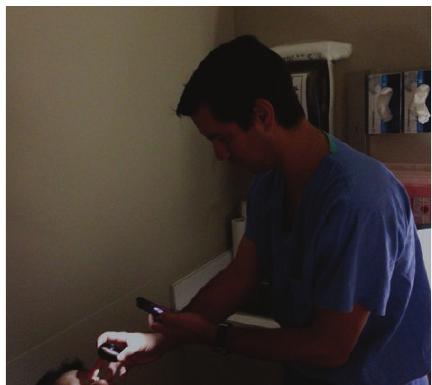
Figure 2: Filming setup with user holding iPhone for filming with Filmic Pro app in one hand and holding 20D lens for focusing on the retina in the other